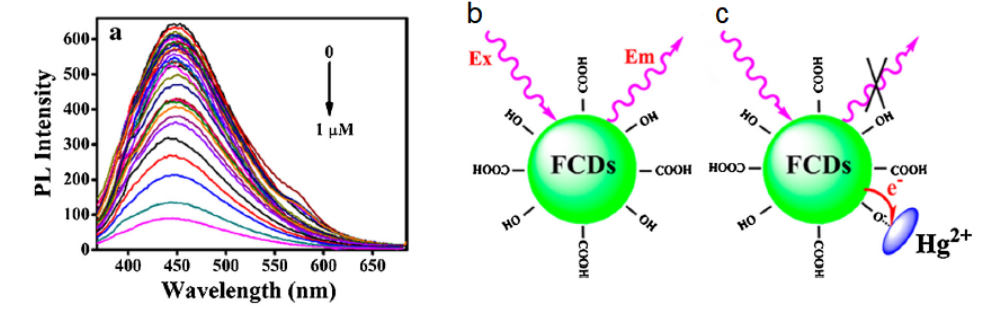
Figure 10. ( a ): emission spectra of CD solution with different amount of Hg 2 + ions. ( b , c ): schematic illustration of fluorescence and quenching mechanisms, respectively. Reproduced with permission from [138]. Copyright Elsevier,